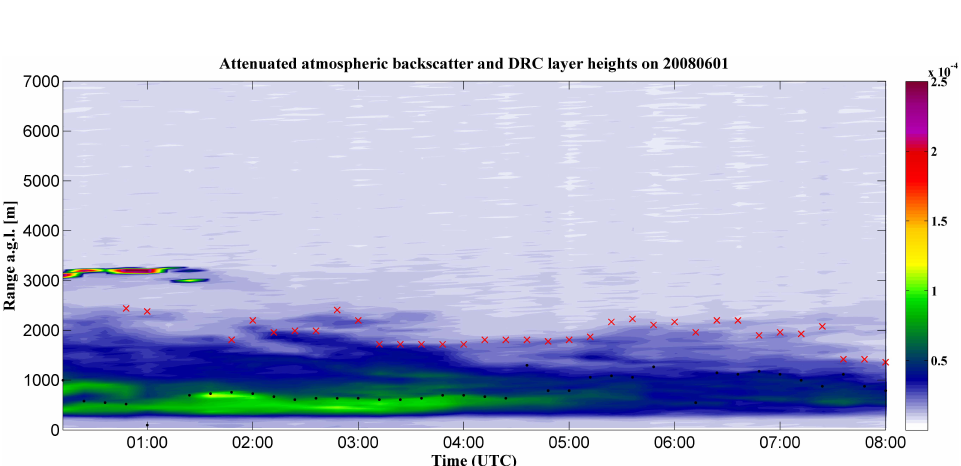
Fig. 2. Decoupled boundary layer on JD153 (01/06/2008). Black points mark the top of the SML while the red crosses mark the top of the overlying DRC layer (the main boundary layer – free troposphere inversion. It should be noted that the lowest 200m represents the region of incomplete overlap between the receiver field of view and the transmitted laser beam and should be disregarded as unusable